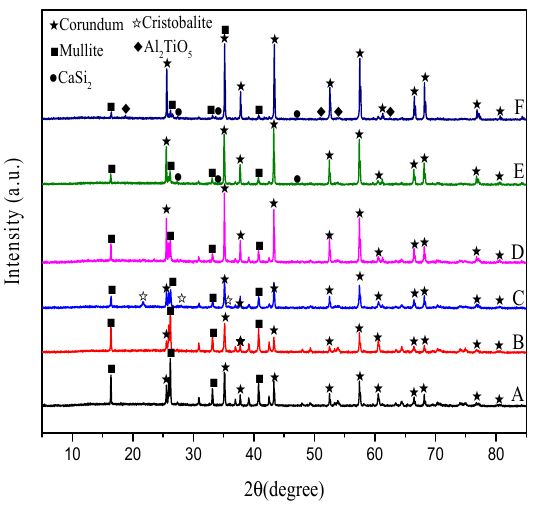
Figure 2. Phase composition of different types of bauxite.